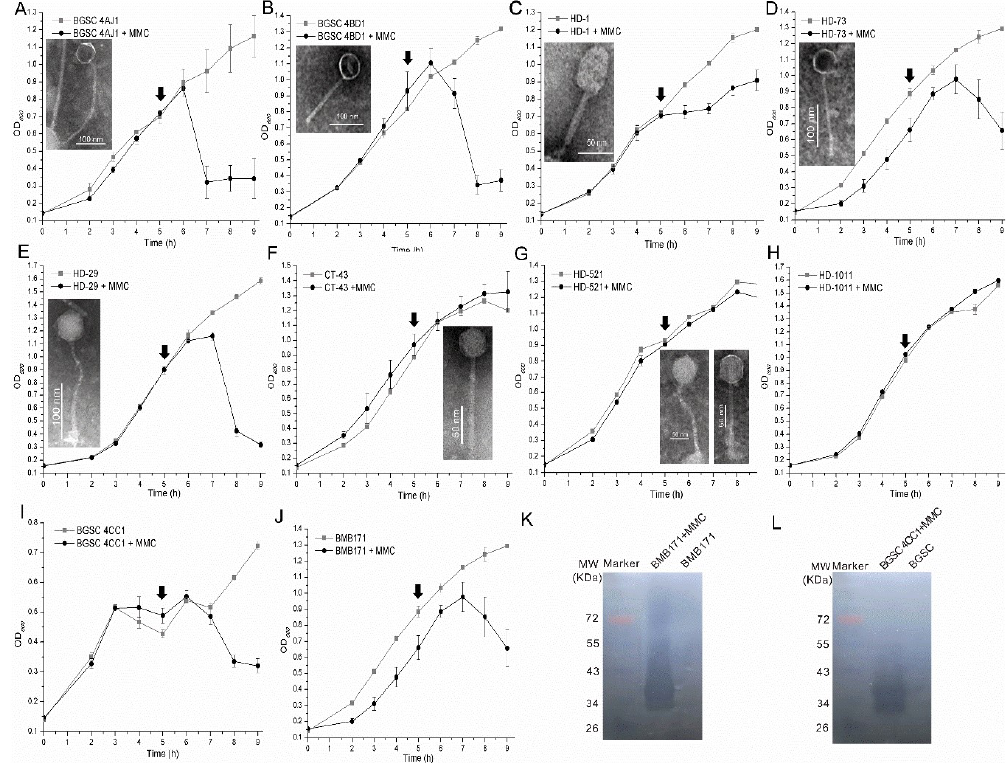
Figure 6. Induction of prophages from Bt strains and characterization of the induced phages. 10 Bt strains, containing putative complete prophage regions, were induced using mitomycin C. Growth curves were plotted ( A – J ). The strains without induction with mitomycin C were used as controls and referred to as the names of the strains, while the strains induced by mitomycin C were indicated by adding MMC to the name. The observed phage virions in the supernatants of the strains were shown ( A – G ). The lytic activity assays of the culture supernatants of strains ( K ) BMB171 and ( L ) 4CC1 were performed using the in-gel approach using the sterilized host cells. The time points of the addition of mitomycin are indicated by black arrows.